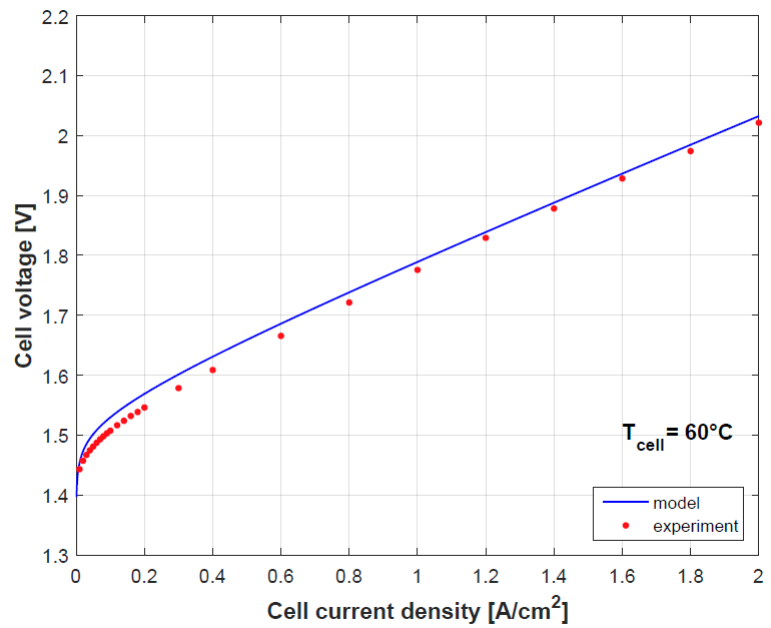
Figure 5. Model prediction and experimental data of the cell polarization at 60 °C.